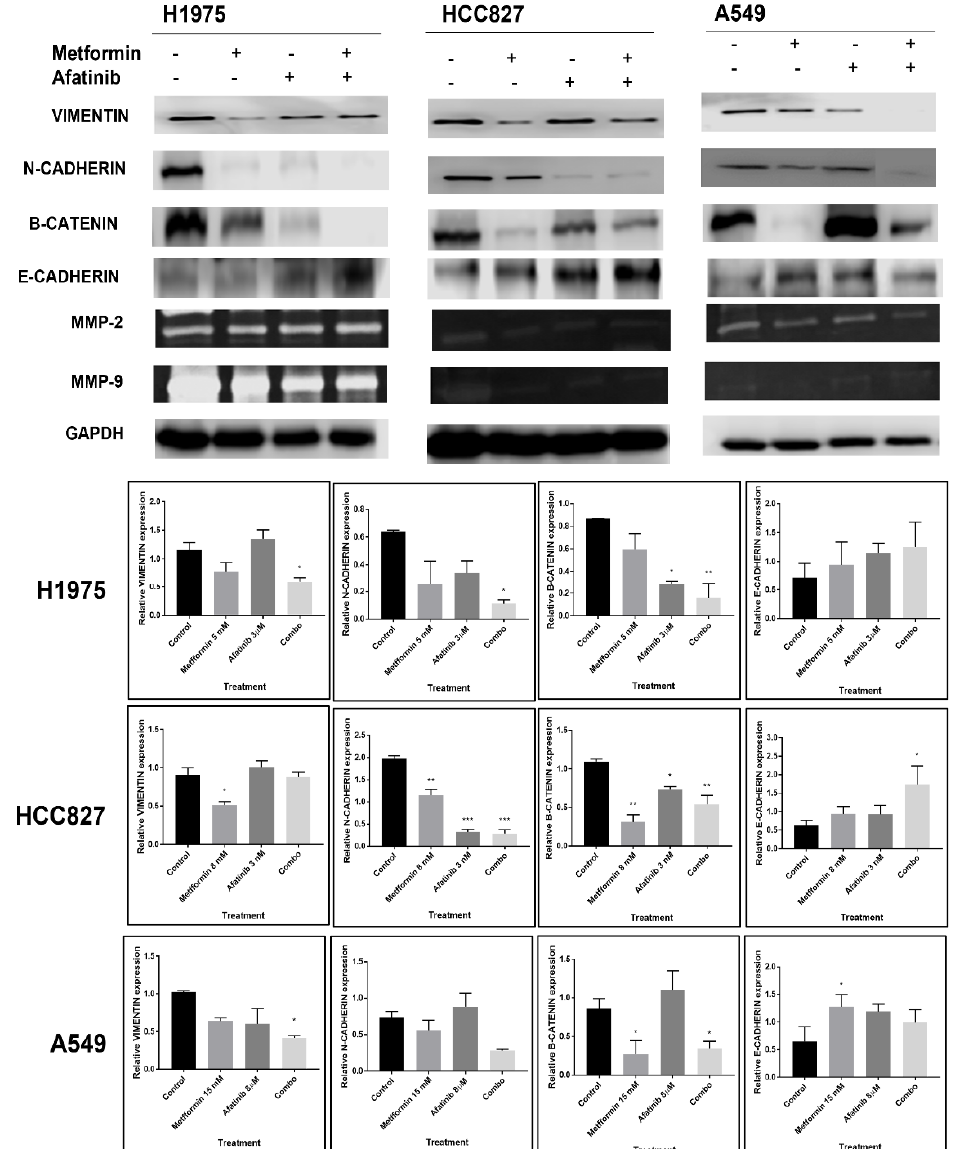
Figure 5. EMT biomarkers in NSCLC cell lines treated with metformin, afatinib, and the combination scheme. Cells were seeded and treated for 72 h with their respective metformin–afatinib concentrations. GAPDH was used as constitutive control, Western blot images were analyzed by image (NIH) and represented as bars. Images are representative of three independent experiments and results of area are presented as mean ± SD. For the zimogram assay, images are representative of two independent experiments. Data were normalized regarding endogenous control and statistically analyzed by one-way ANOVA. * p ≤ 0.05, ** p ≤ 0.01, *** p ≤ 0.001.